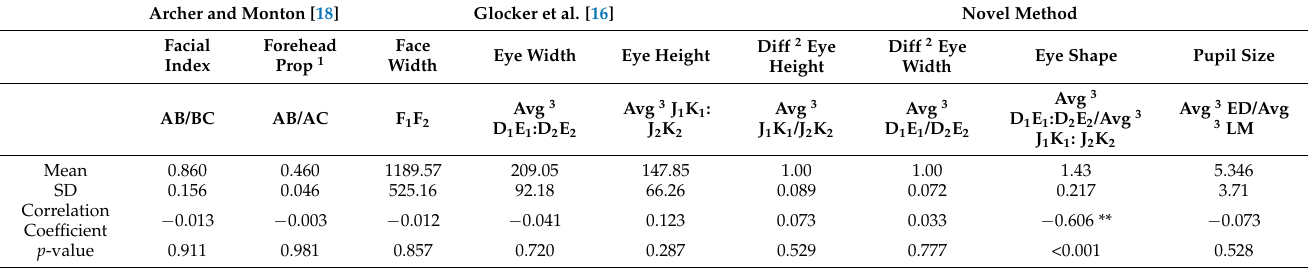
Table 1. Relationship between subjective cuteness ratings and objective facial measurements from images (n = 77) in survey 1 using Spearman’s rank-order